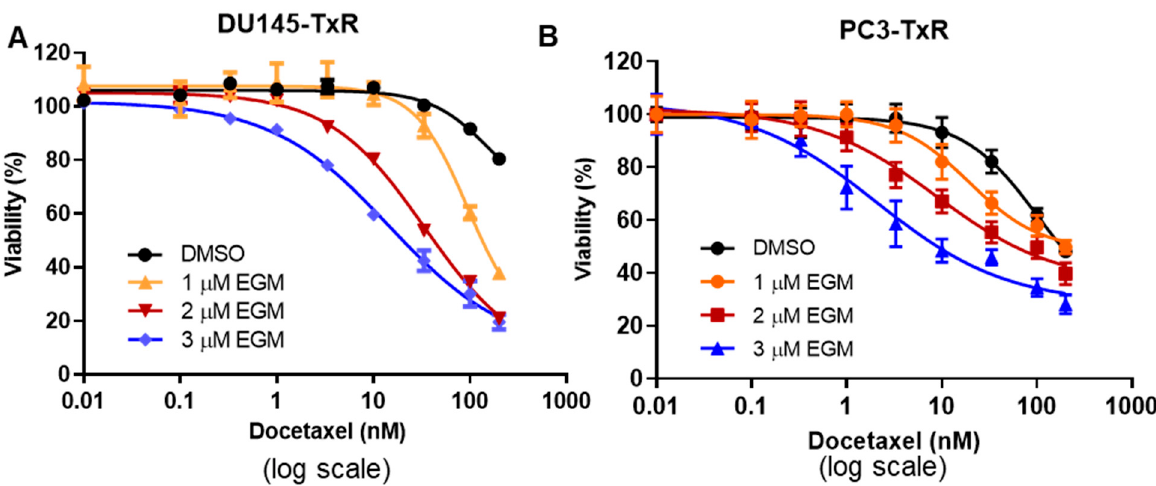
Figure 5. Treatment with the combination of Eggmanone and docetaxel dramatically overcomes prostate cancer cell chemo-resistance. ( A ) the chemo-resistant prostate cancer DU145-TxR cells were treated with both Eggmanone (1 µM, 2 µM and 3 µM) and docetaxel (0, 0.1, 0.33,1, 3.3, 10, 33.3, 100 and 200 nM) for 72 h. The control cell viability (no DTX) was designated as 100%. Cell viabilities were normalized to the control (no DTX) and cell viability at different DTX concentrations with 1 µM, 2 µM or 3 µM Eggmanone was plotted. The result showed that Eggmanone dose-dependently increased cytotoxicity of docetaxel to chemo-resistant DU145-TxR. ( B ) The chemo-resistant prostate cancer PC3-TxR cells were treated with both Eggmanone (1 µM, 2 µM and 3 µM) and docetaxel (0, 0.1, 0.33,1, 3.3, 10, 33.3, 100 and 200 nM for 72 h. The control cell viability (no DTX) was designated as 100%. Cell viabilities were normalized to the control (no DTX) and cell viability at different DTX concentrations with 1 µM, 2 µM or 3 µM Eggmanone was plotted. The result showed that Eggmanone dose-dependently increased cytotoxicity of docetaxel to chemo-resistant Table 1. Docetaxel IC50 to chemo-resistant prostate cancer cells is decreased along with elevation of Eggmanone in a dose dependent way.